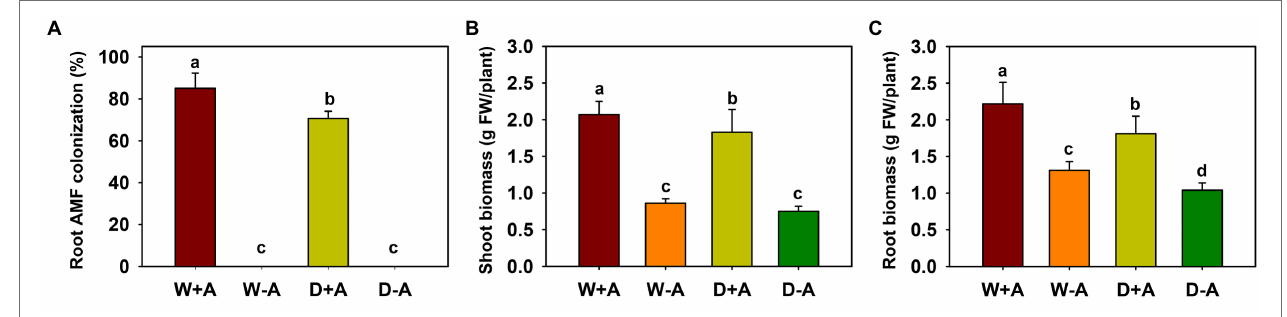
FIGURE 1 | Changes in root mycorrhizal colonization (A) , shoot biomass (B) , and root biomass (C) of trifoliate orange seedlings under well-watered and drought stress conditions after inoculation with Rhizophagus intraradices . Different letters above the bar indicate significant differences at p < 0.05. Abbreviation: W + A, inoculation with R . intraradices under well-watered conditions; W-A, inoculation without R . intraradices under well-watered conditions; D + A, inoculation with R . intraradices under drought stress conditions; D-A, inoculation without R . intraradices under drought stress conditions.